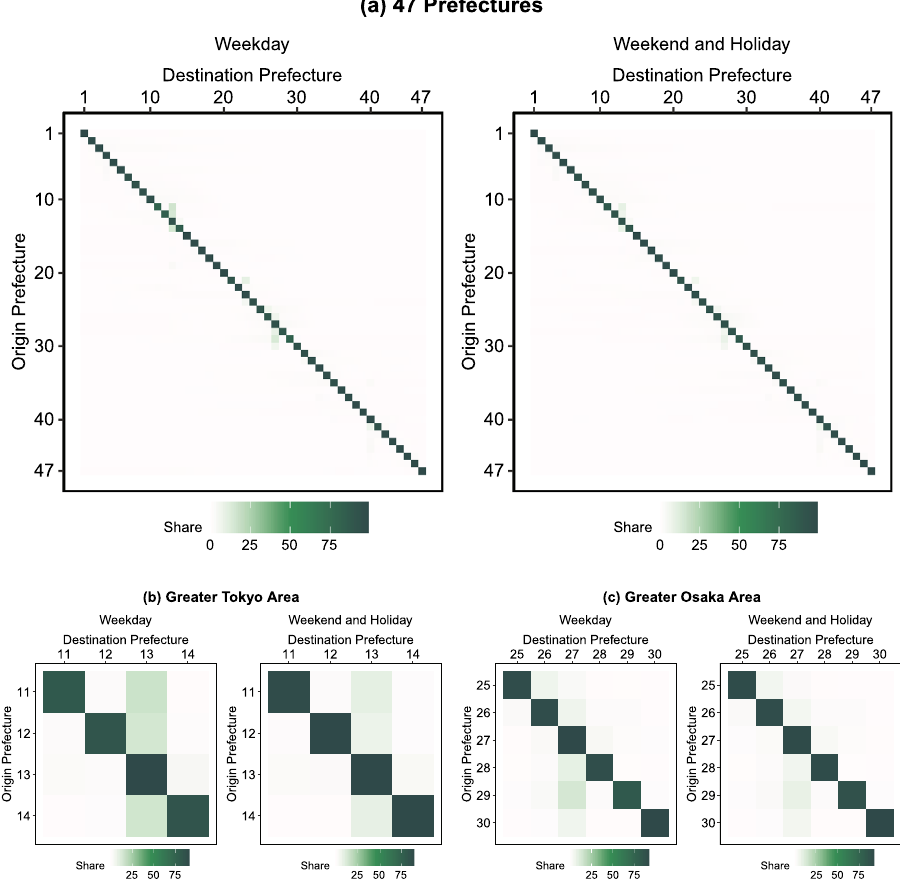
Figure 3. Origin–Destination matrix between prefectures, constructed from the interregional mobility data obtained by the “From–To Analysis” function of the RESAS app (supported by Mobile Spatial Statistics of NTT DOCOMO 52 ). The tile plot shows the OD flows at 2 pm in April 2016.